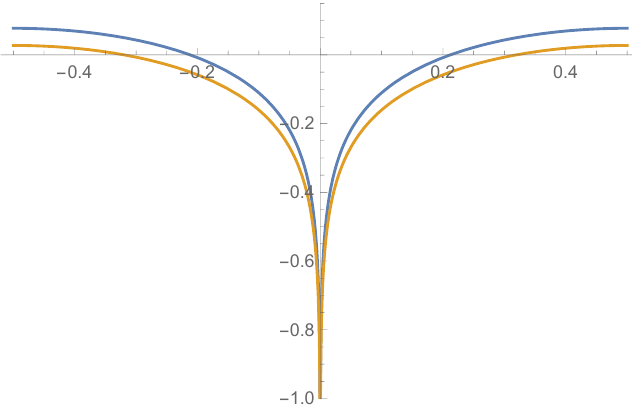
Figure 6. Comparison of the graphs of the two Green’s function expressions ~ G (A.21) and G (A.23) along ~(cid:27) = ( (cid:27) 1 ; 0), for (cid:28) = i. The lower orange curve is G and the upper blue curve is ~ G (cid:0) ~ G ( (cid:27) 1 = 1 ) + G ( (cid:27) 1 = 1 ) + 0 : 05. The constant between the functions is adjusted by the value at (cid:27) 1 = 1 2 2 and we add on the graph a shift of 0 : 05 to be able to see both curves; without the latter, they are simply indistinguishable. The same perfect match is observed along ~(cid:27) = ( (cid:27); (cid:27) ) for which we do not display the graph